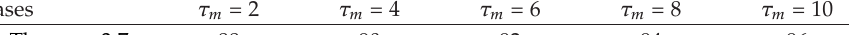
Table 3: Allowable upper bounds τ